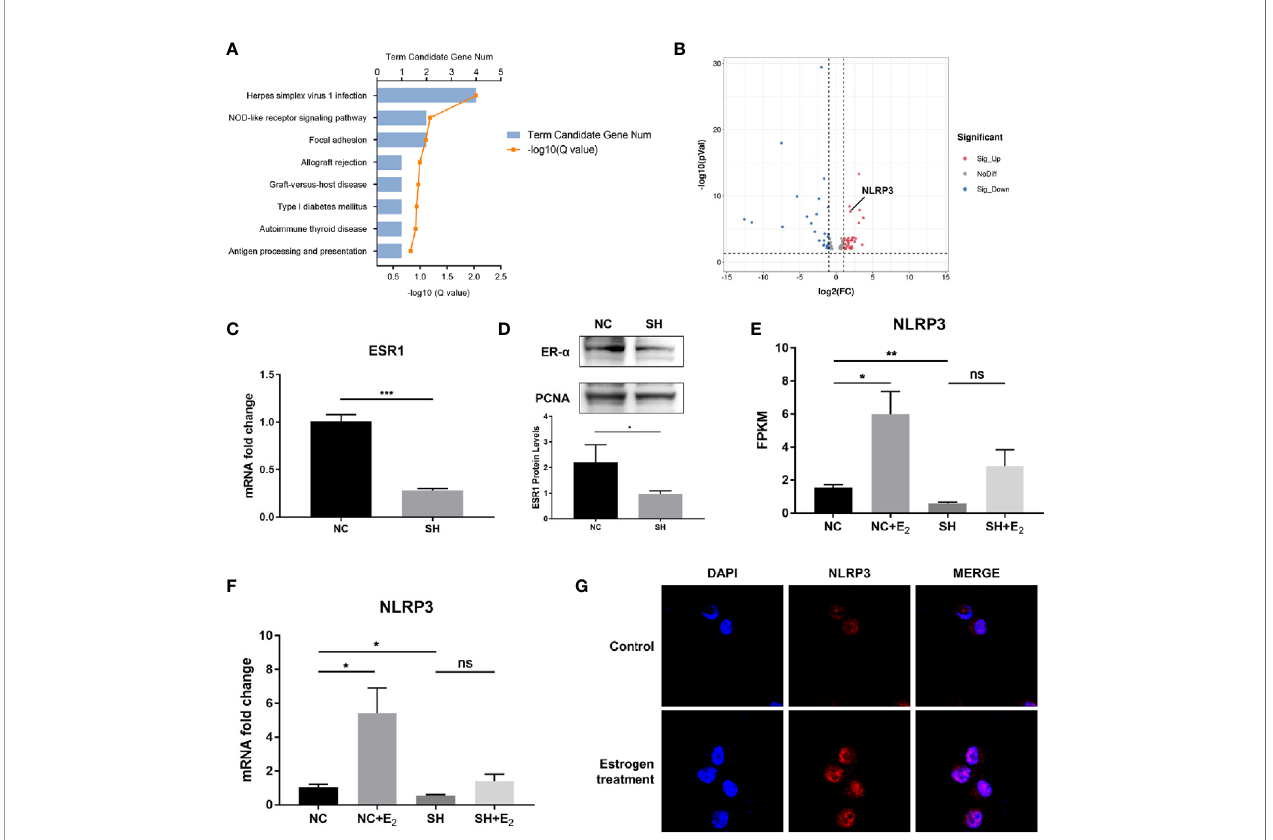
FIGURE 1 | NLRP3 expression was increased by estrogen stimulation via ER- a in MCs. (A) Bar plot of differentially expressed genes (DEGs) from the KEGG pathway enrichment analysis; a comparison between b -estradiol treated P815 cells and the control. (B) A volcano plot was used for visualization of the differentially expressed genes. The gray point in the plot represents genes with no statistical differences (-1< log 2 (FC) < 1, P > 0.05), the red point represents upregulated genes (log 2 (FC) > 1, P < 0.05), and the blue point represents downregulated genes (log 2 (FC) < -1, P < 0.05) with statistical signi fi cance. (C) Quantitative PCR analysis of ESR1 in P815 cells after ESR1-speci fi c shRNA transfection. (D) Western blot analysis of ER- a in P815 cell nuclei after stable transfection of ESR1-speci fi c shRNA. (E) Relative quanti fi cation of NLRP3 mRNA level in P815 was measured by FPKM reads using RNA-seq. (F) Quantitative PCR analysis NLRP3 mRNA levels in P815 cells treated with b -estradiol after knockdown of ESR1 compared with the negative control. (G) Representative images of immuno fl uorescence staining for NLRP3 (red) in mast cell line P815 incubated with or without 100 pmol/mL b -estradiol for 24 h Data in (C, D, F) represent three independent experiments. Data are expressed as mean ± SEM. Statistics: Unpaired Student ’ s t-test. * P < 0.05, ** P < 0.01, *** P < 0.001; ns, statistically not signi fi